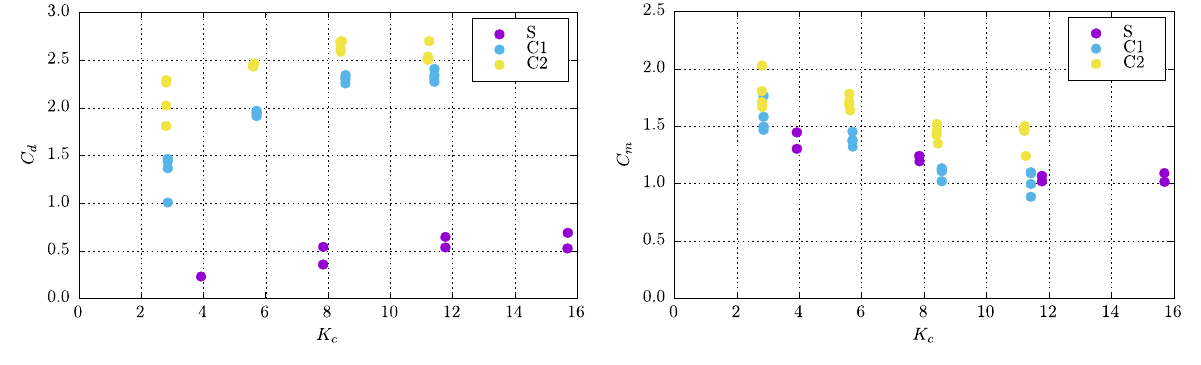
Figure 11. Evolution of C d ( left ) and C m ( right ) vs. KC .